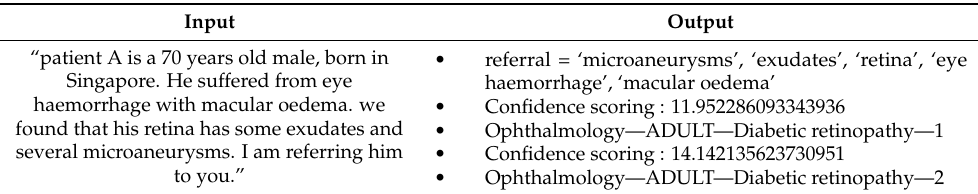
Table 3. Test referral input and output of CPC’s condition matching.